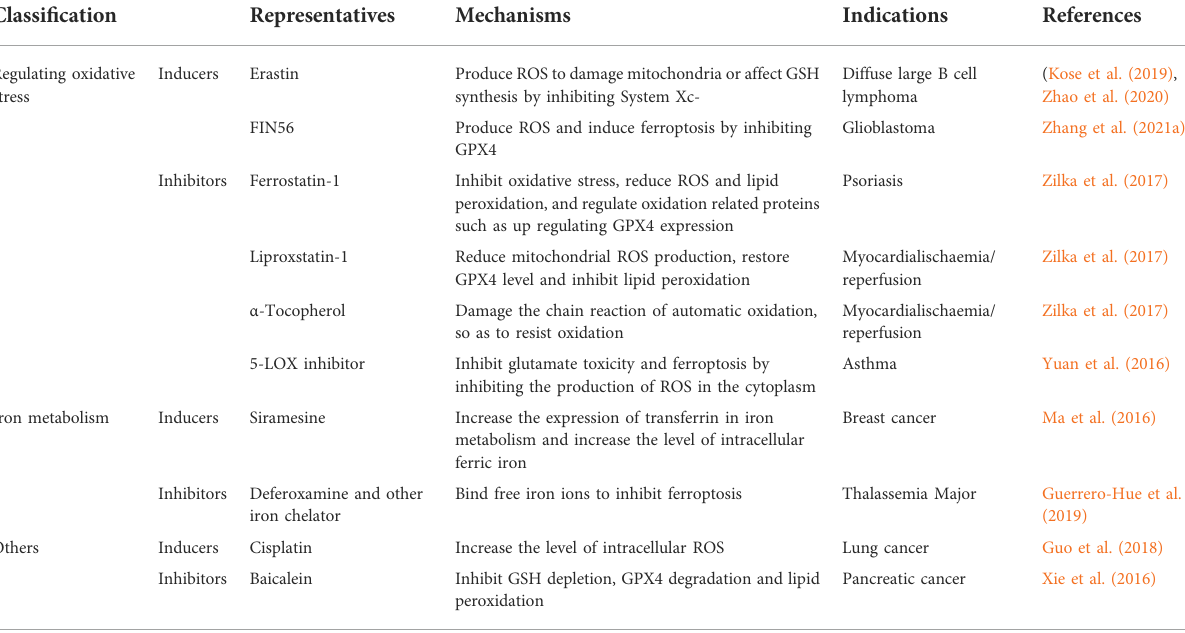
TABLE 1 The use of ferroptosis inducers and inhibitors in